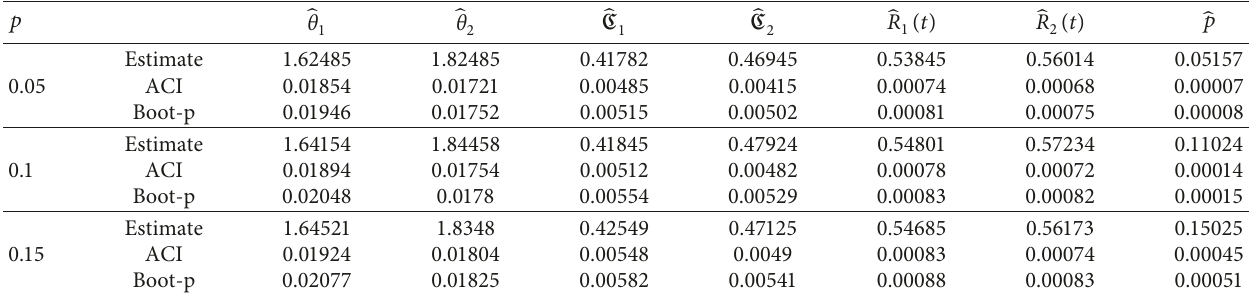
Table 15: ML estimates of parameters and their functions with their length of confidence interval for different m for n and p .